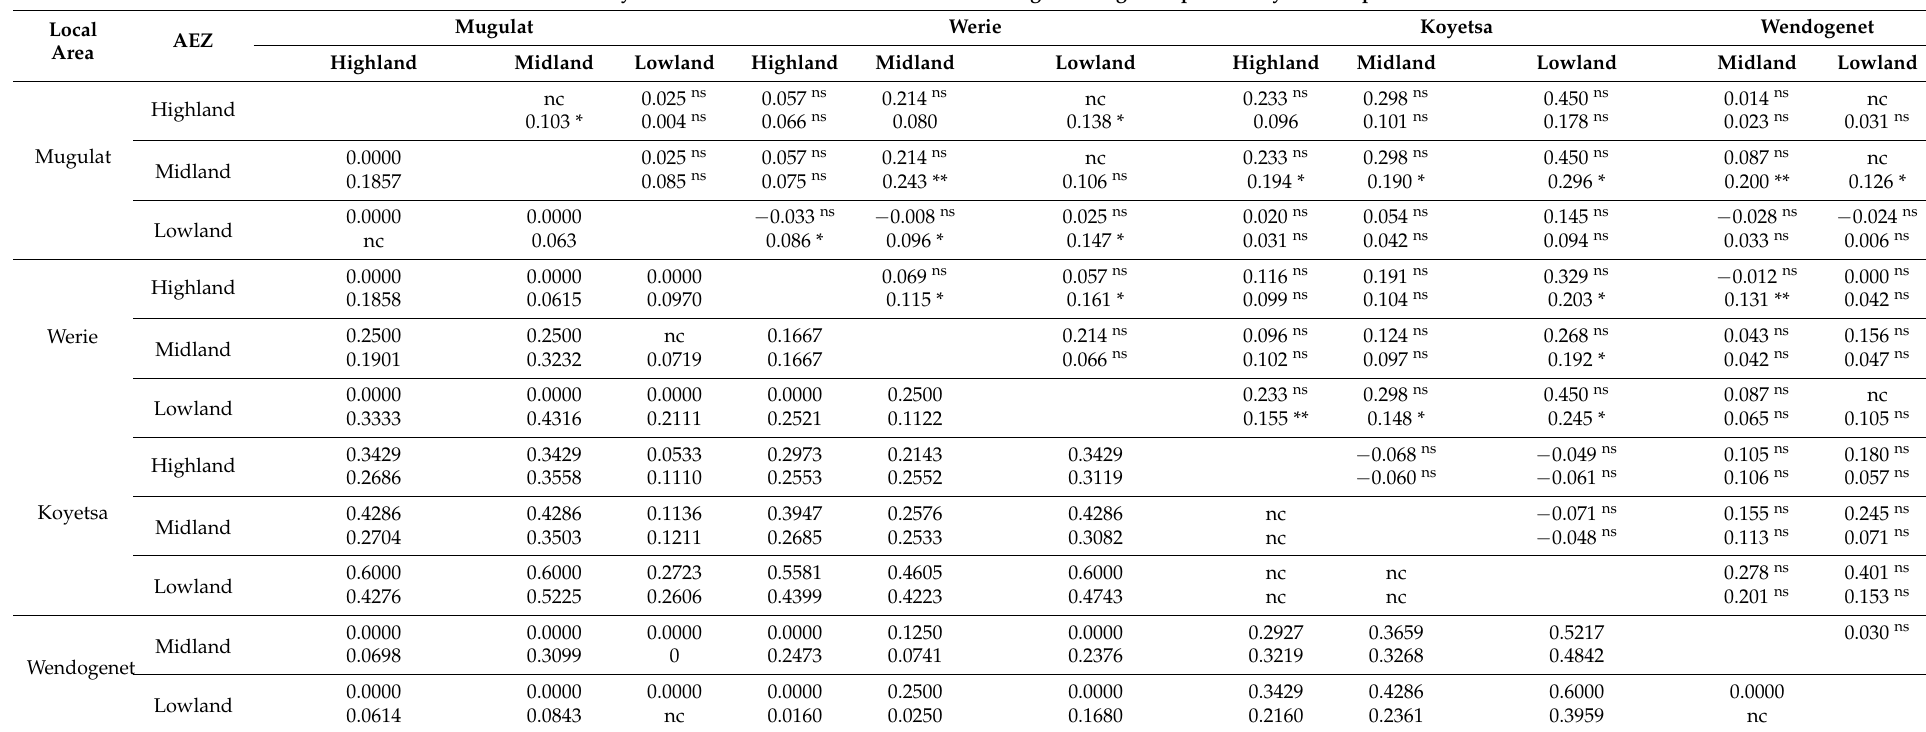
(b) Analysis based on the mitochondrial COI-COII region using Ethiopian honey bee